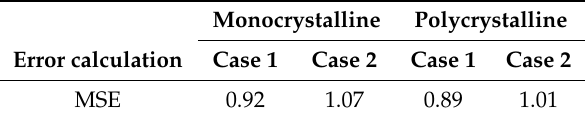
Table 11. Mean squared error (MSE) from simulated and experimental I–V curves for model